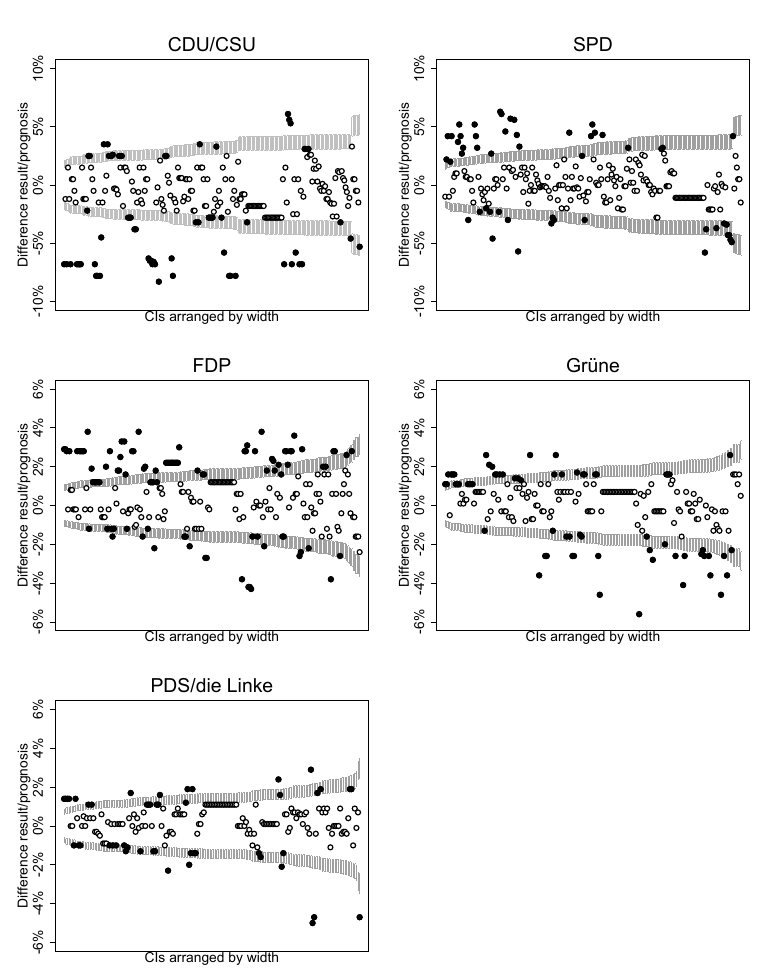
Figure 3 : Width of naïve binomial 95%-CIs without deft (inner) in comparison to binomial 95%-CIs with deft (outer) and election results. The naïve CIs without deft corresponding to the results marked as ○ contain the election results; the naïve CIs without deft corresponding to the results marked with ● do not contain the election